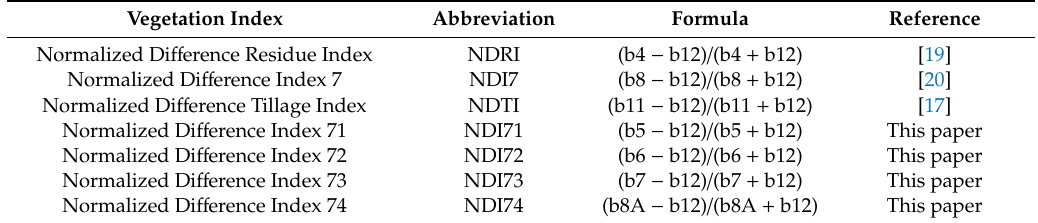
Table 1. Table 1. The selected optical crop residue indices used in this